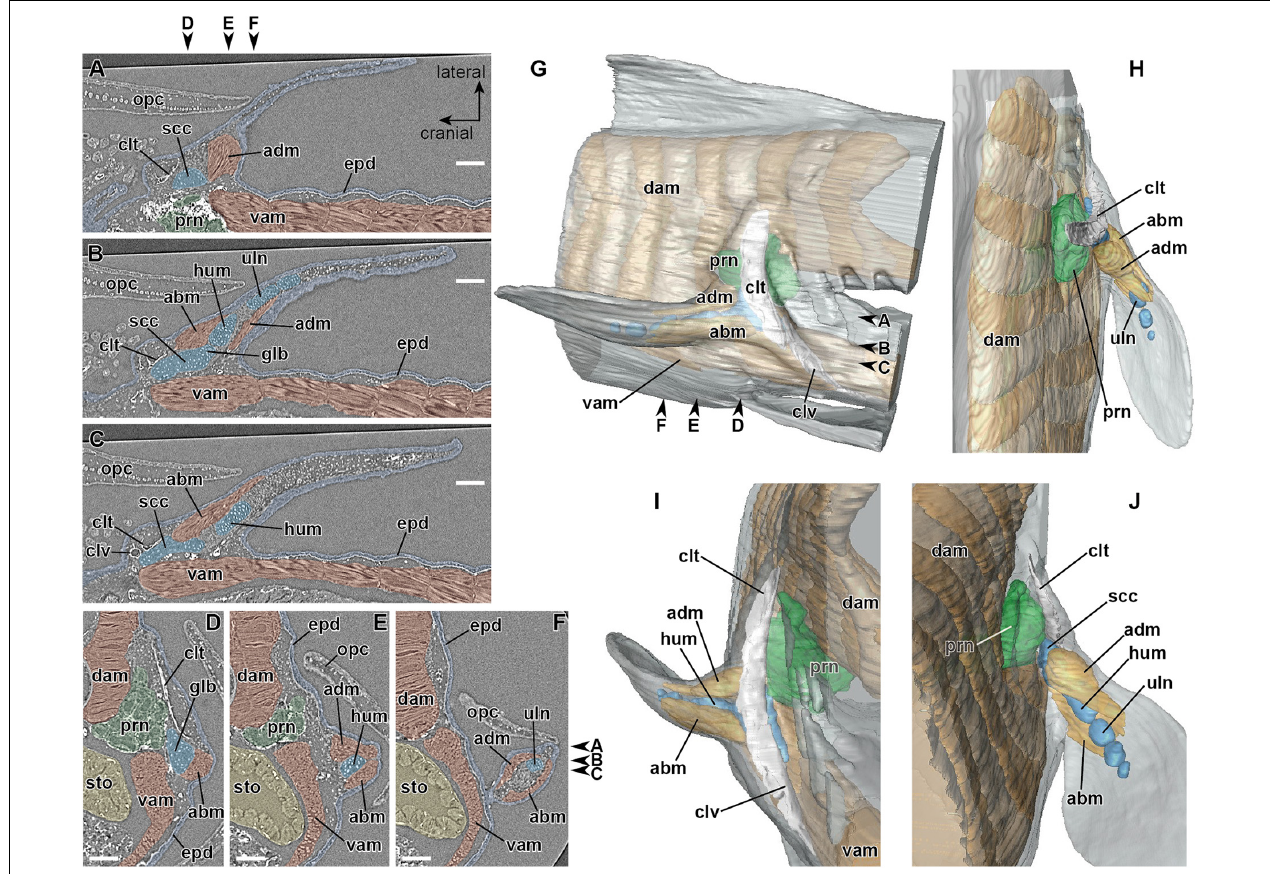
FIGURE 3 | Developing right pectoral fin of Neoceratodus forsteri during the late phase of stage 47 (total length = 17.5 mm). (A–C) Coronal section. (D–F) Transverse section. (G) Lateral view. (H) Dorsal view. (I) Cranial view. (J) Caudal view. abm, abductor muscle; adm, adductor muscle; clt, cleithrum; clv, clavicle; dam, dorsal axial muscle; epd, epidermis; glb, glenoid buttress of the scapulocoracoid; hum, humerus; opc, operculum; prn, pronephros; scc, scapulocoracoid; sto, stomach; uln, ulna; vam, ventral axial muscle. Arrowheads indicate the respective sectioned levels. Scale bar = 200 µ